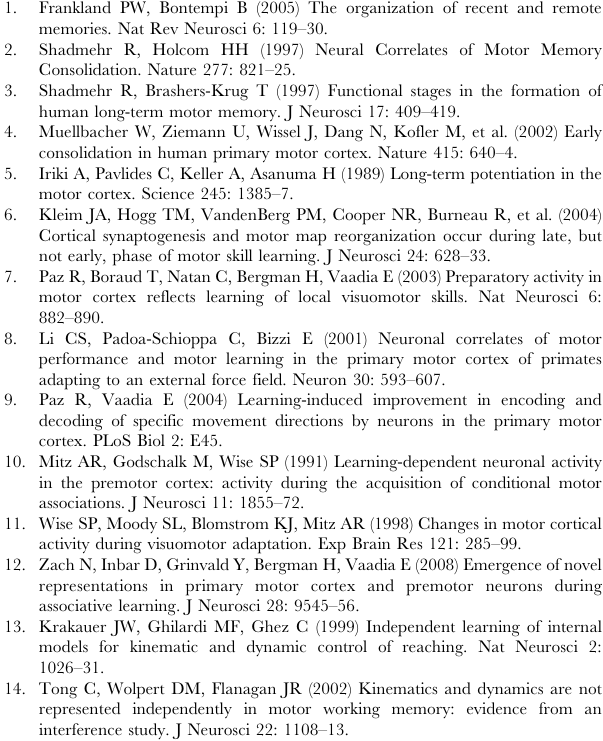
Figure S1 Experimental design and behavioral results.